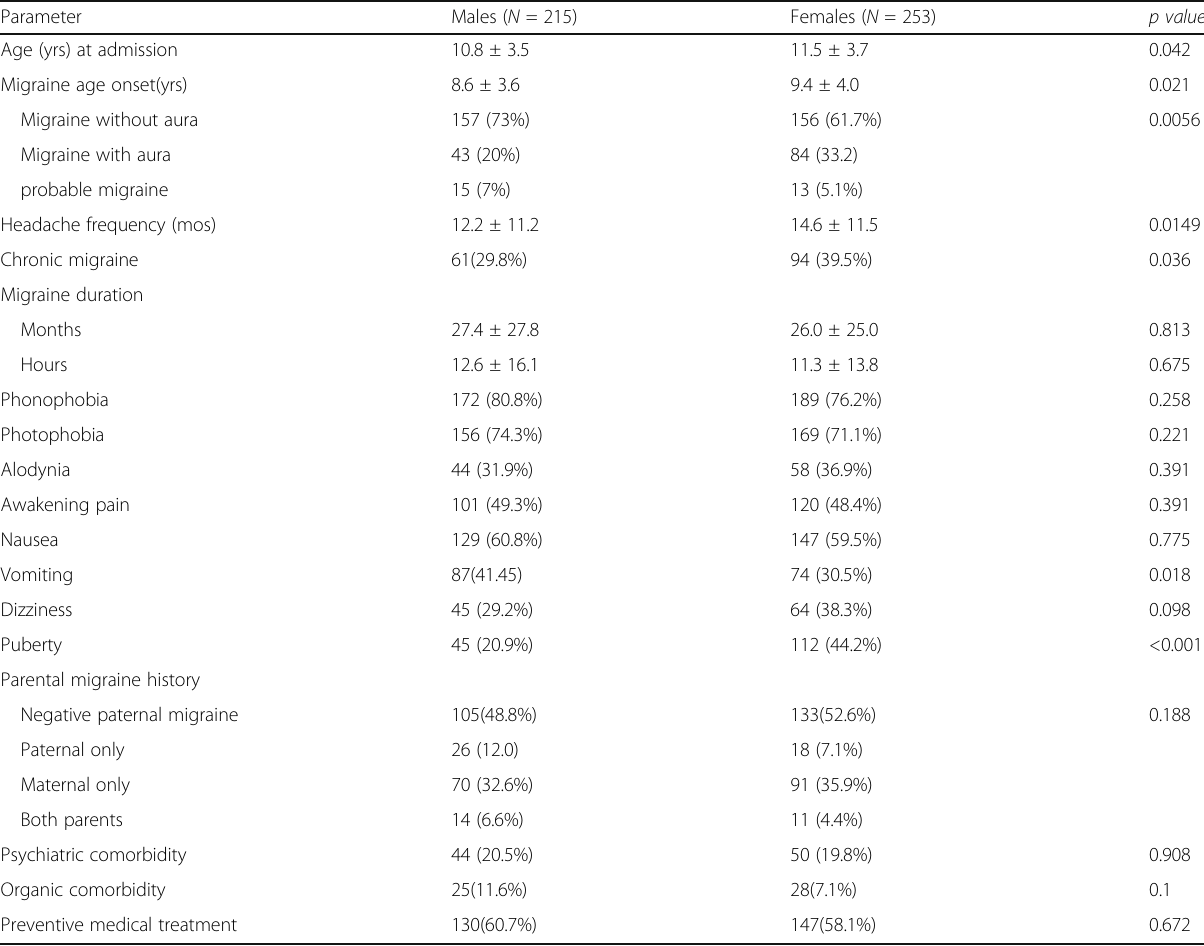
Table 1 Demographic and clinical parameters of pediatric patients with migraine (468 patients)